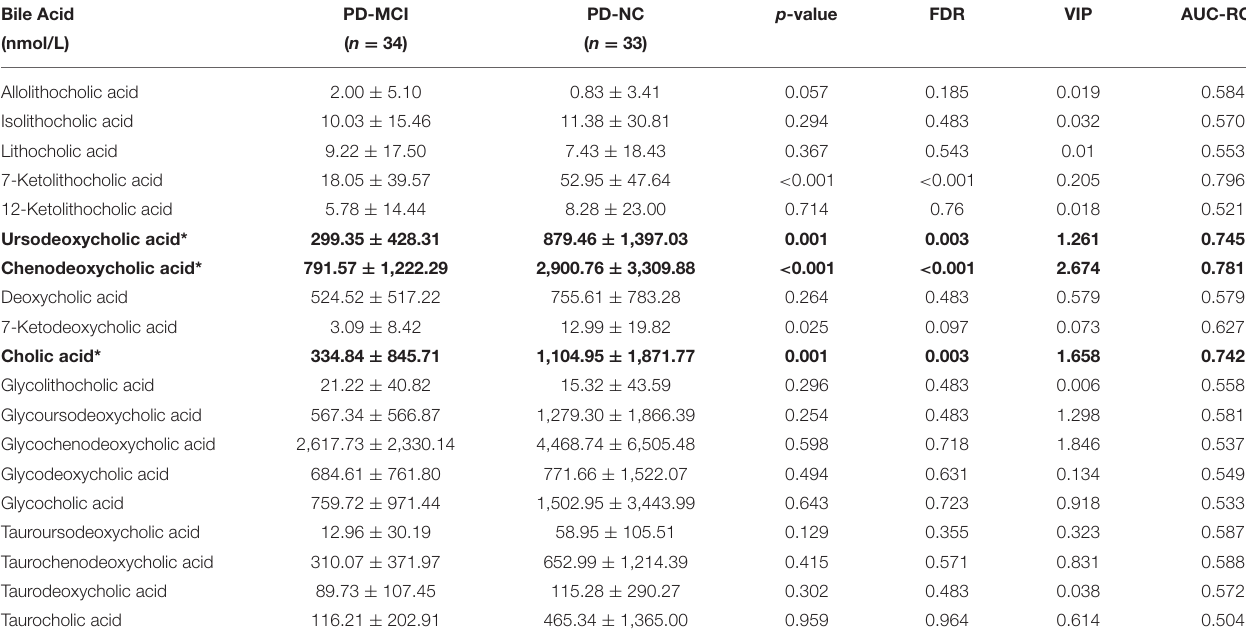
TABLE 2 | The bile acid profile in different groups of patients. Bile